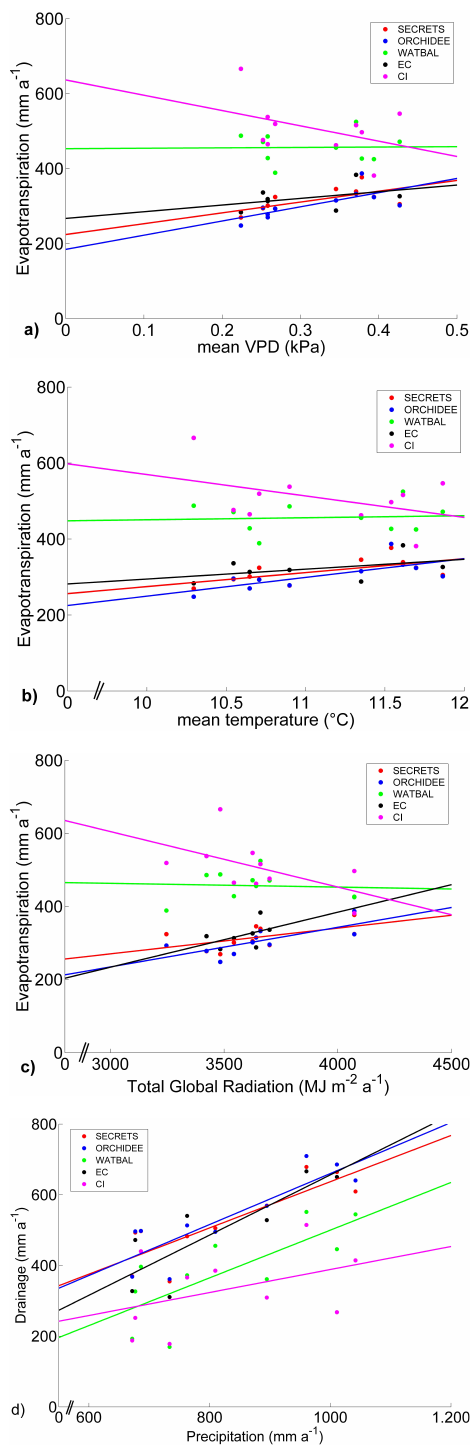
Fig. 8. Linear regression lines for three main drivers of ET on annual scale for the five different approaches (SECRETS, OR- CHIDEE, WATBAL, eddy covariance [EC], eddy covariance [EC], Conservative Ion (CI)) examined in this study. Total global radi- ation (a) , mean annual temperature (b) and mean VPD (c) . The lower right panel shows (d) the relation between annual drainage (ordinate) and precipitation